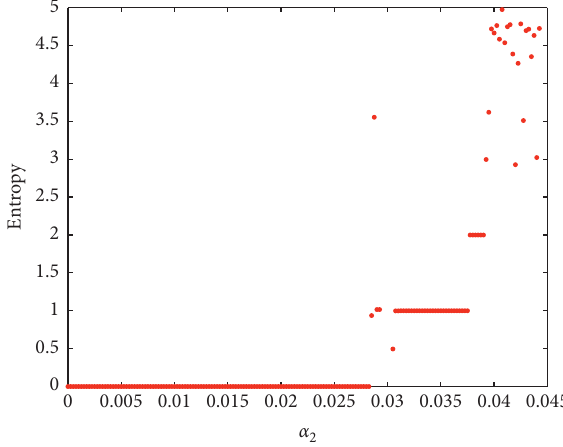
Figure 4: Entropy diagram of the system (17) with varying α � 0 . α 1